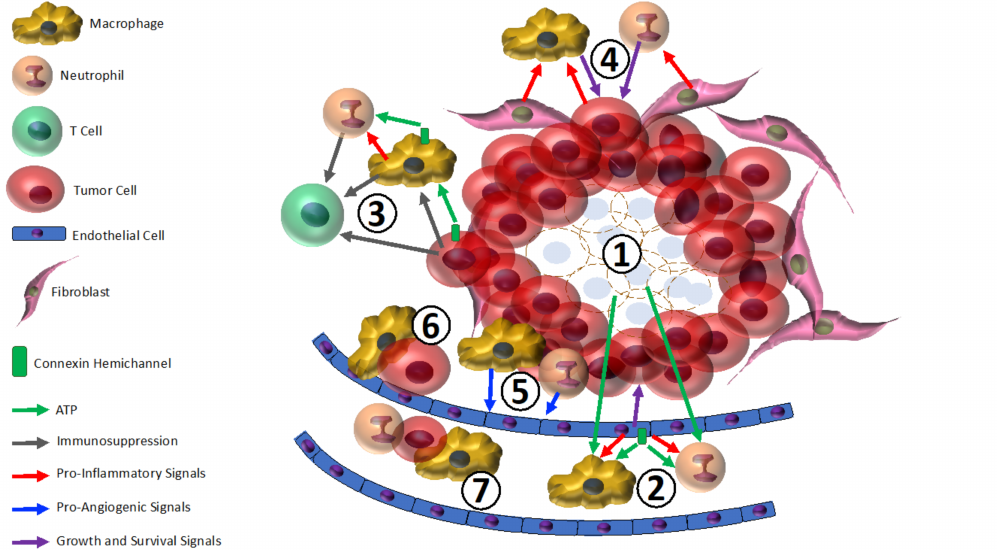
Figure 1. Connexin hemichannels and tumor-associated inflammatory cells in mammary tumor progression. 1 (cid:13) Damage-associated molecular patterns (DAMPs), including ATP, that attract and activate macrophages and neutrophils are released from ruptured cells at the necrotic core of the tumor, and from tumor cells necrosing in response to therapy; 2 (cid:13) Vascular endothelial cells secrete ATP through hemichannels in response to tumor-related stress, attracting macrophages and neutrophils. Endothelial cells also secrete TNF- α , which promotes tumor growth and inflammation; 3 (cid:13) Tumor cells may release ATP from hemichannels triggered to open by the cellular stressors intrinsic to tumor cell physiology. This can activate local macrophages (i.e., tumor-associated macrophages (TAMs)) that in turn produce pro-inflammatory cytokines. TAMs may also release neutrophil-recruiting ATP from hemichannels. In addition, tumor cells express ectonucleases that convert ATP to adenosine, which has immunosuppressive effects on tumor-associated neutrophils (TANs), TAMs, and T cells; 4 (cid:13) Breast cancer cells and cancer-associated fibroblasts (CAFs) produce pro-inflammatory cytokines that attract and activate TAMs and TANs. In turn, TAMs and TANs produce pro-survival and pro-growth signals that promote tumor progression; 5 (cid:13) TAMs and TANs produce pro-angiogenic factors that stimulate tumor vascularization; 6 (cid:13) TAMs aid metastatic tumor cells in intravasation; 7 (cid:13) TAMs and TANs may chaperone tumor cells through the vasculature to sites of